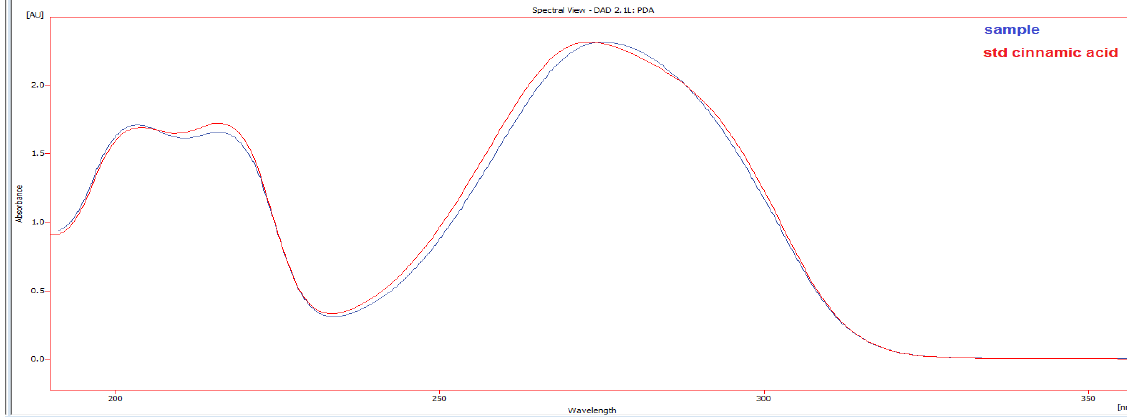
Figure 18. UV spectrum of cinammic acid std and isolated cpdC3 FTIR: IR spectrum of isolated cpd C3 was showed in the figure (19) and interpretation of the bands in the table (7)